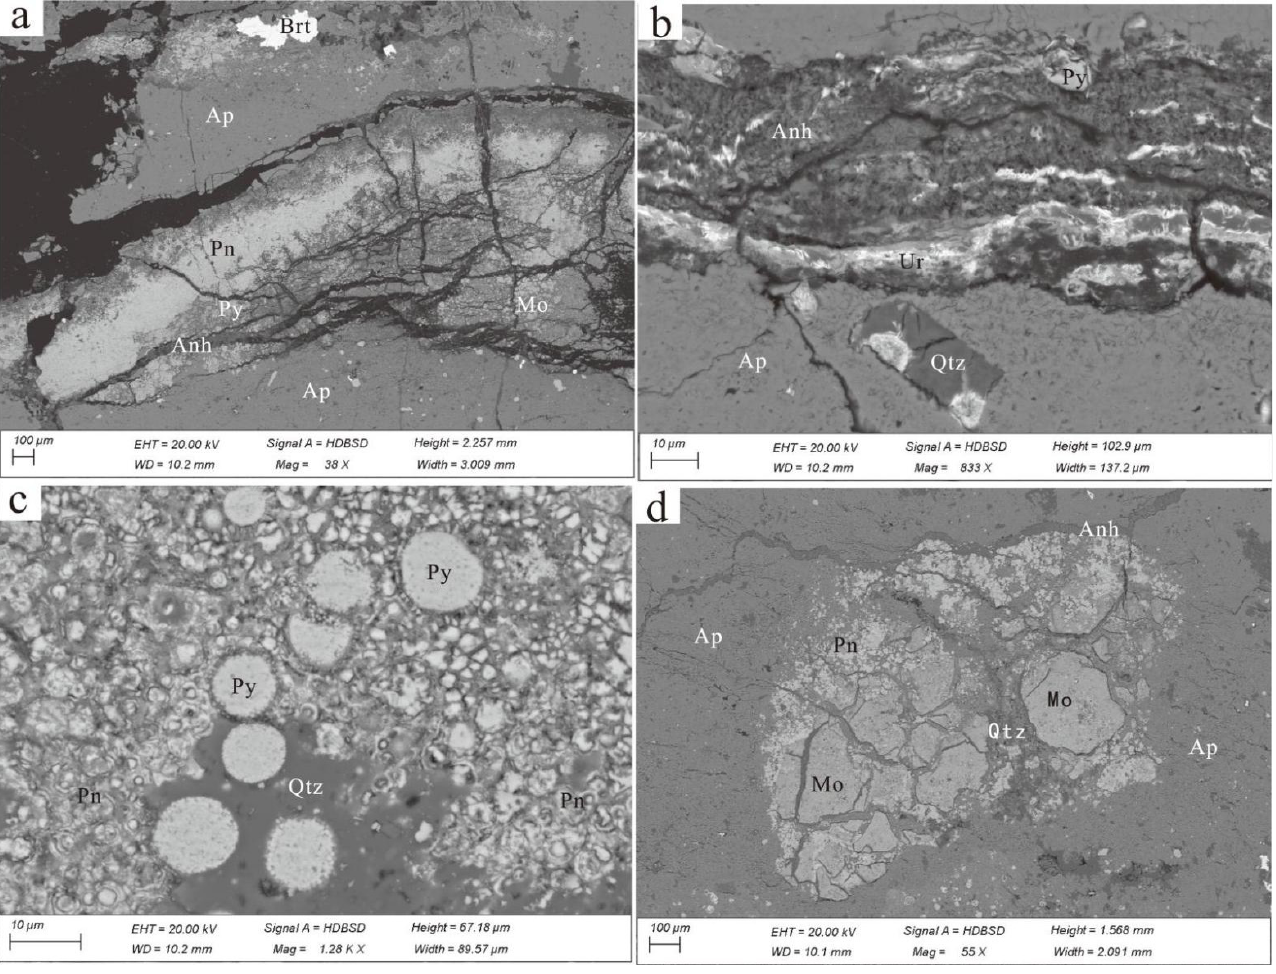
Figure 5. The backscattering image of the uranium-polymetallic phosphorite. Ap—Apatite; Pn— Pentlandite; Py—Pyrite; Mo—Molybdenite; Anh—Anhydrite; Qtz—Quartz; Ur—Uraninite; Brt— Barite. ( a ) Spatial relationship of minerals; ( b ) pitchblende, gypsum and pyrite distributed along fractures; ( c )strawberry pyrite; ( d )Mass distribution of nickel pyrite and molybdenite.